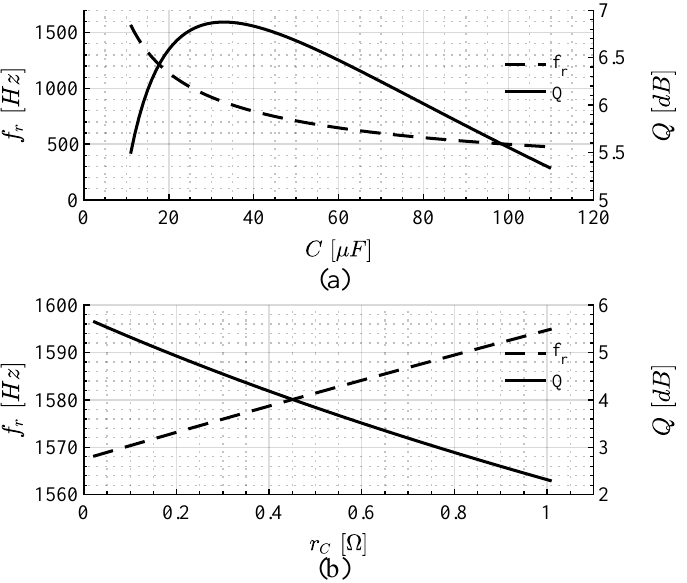
Figure 12. Variation of the resonant frequency and Q as: ( a ) C is varied and ( b ) r C is